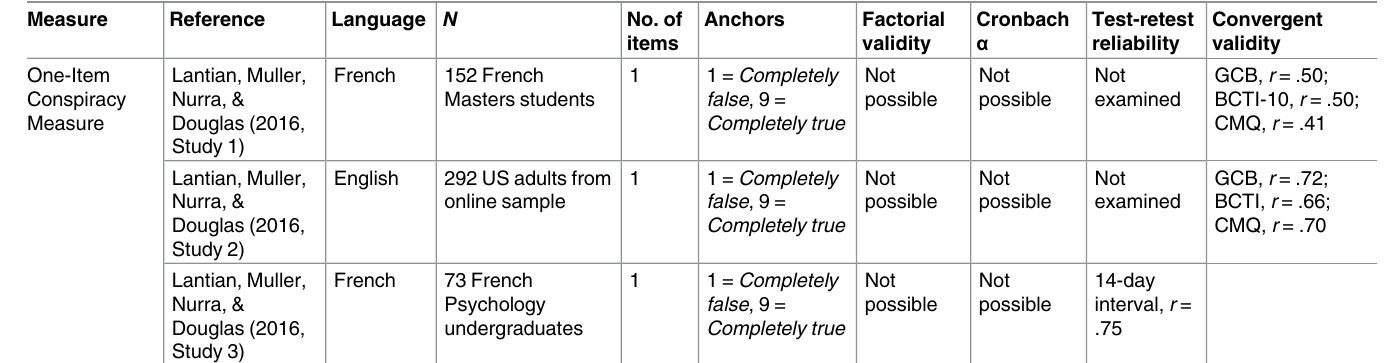
Table 3. One-Item Conspiracy